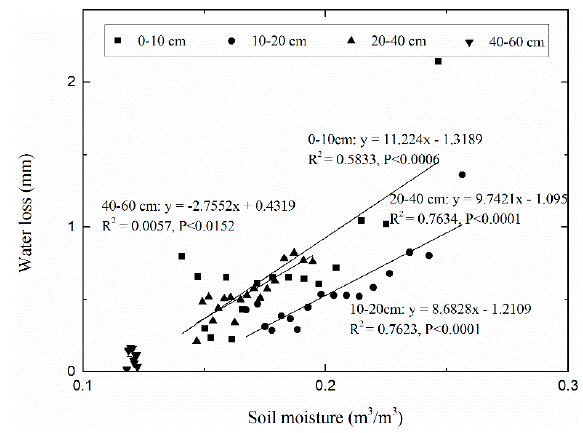
Figure 8. The regression relationship between water loss and soil moisture at different soil depths in grassland.